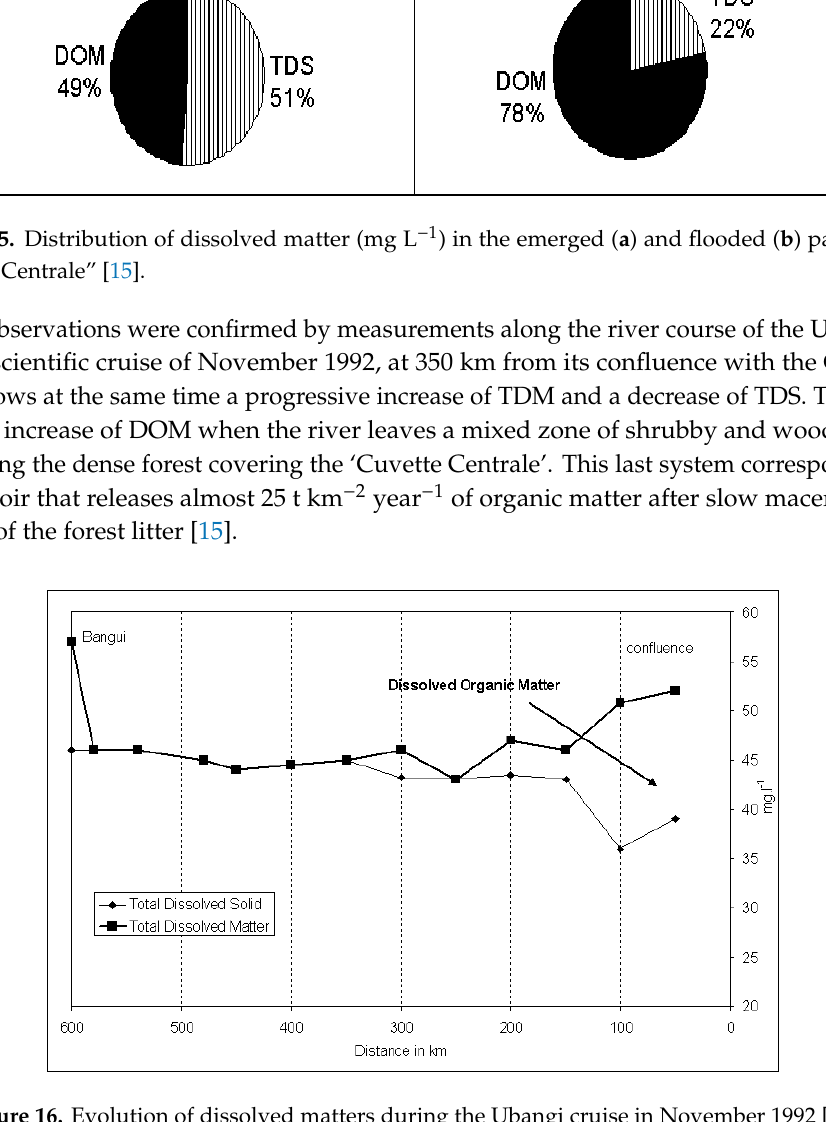
Figure 14. ( a ) Mean monthly discharge (Q), Total Suspended ‐ Sediment (TSS), Total Dissolved Solid (TDS) and Dissolved Organic Carbon (DOC) concentrations and their ( b ) fluxes of the Congo River at Brazzaville (for the period 2006–2017) [56].